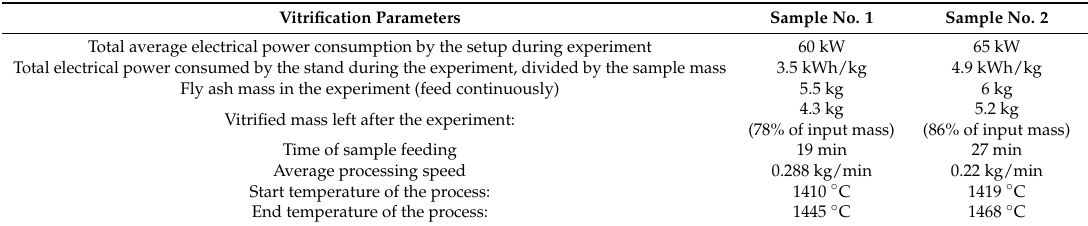
Table 2. Process parameters and conditions for each sample.